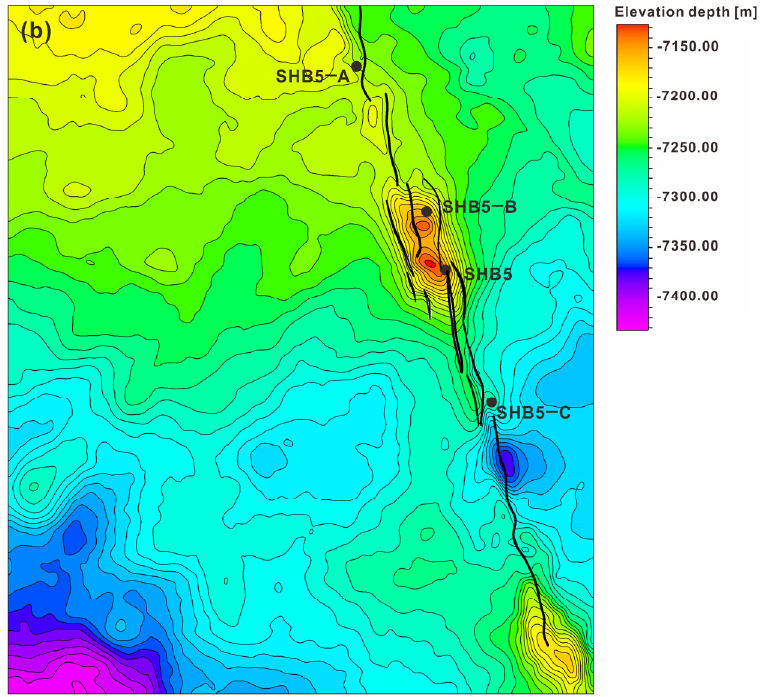
Figure 4. ( a ) The Variance cube on the top of the Yijianfang formation (T 74 ) in the Shunbei 5 area. L1–L17 is the mark of sample lines. ( b ) Tectonic map of the study area.